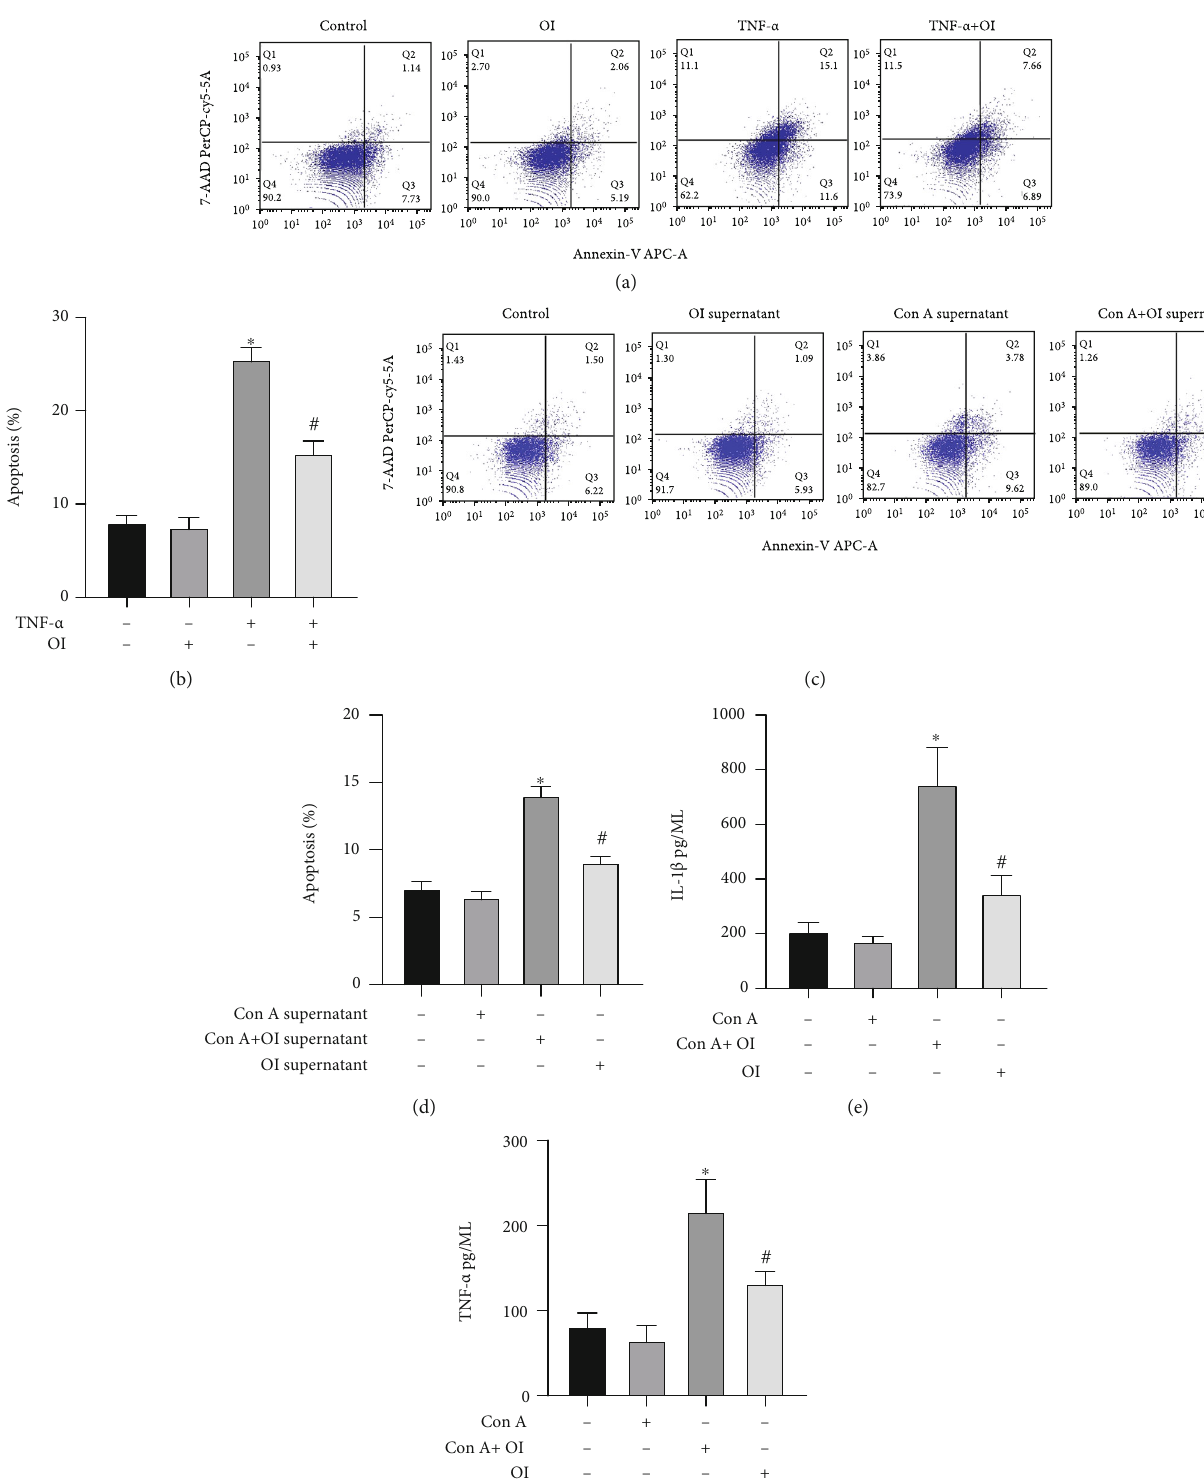
Figure 7: OI inhibited TNF- α , or supernatants from Con A-treated RAW264.7 cells induced hepatocyte apoptosis. (a, b) TNF- α signi fi cantly induced apoptosis in hepatocytes, whereas OI attenuated this change. RAW264.7 cells were treated with Con A and/or OI for 12 h, and the supernatants were added into AML12 cells for 24h. Flow cytometry was used to detect (c, d) hepatocyte apoptosis, and the supernatants were collected to detect the levels of (e) IL-1 β and (f) TNF- α . ∗ p < 0 : 05 vs. control group; # p < 0 : 05 vs. Con A or TNF- α group. Data are expressed as mean ± SEM